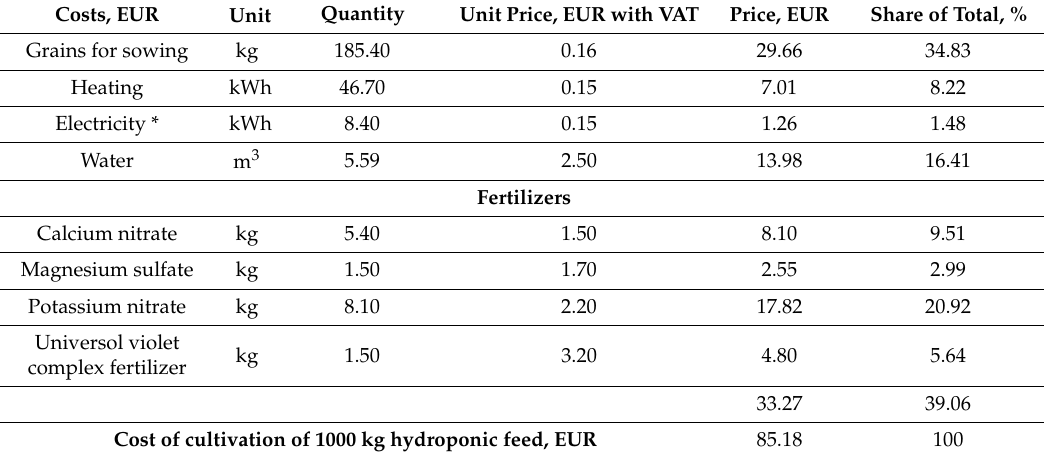
Table 2. Cost (EUR with value added tax (VAT)) of 1000 kg hydroponic feed (14.7% dry matter).